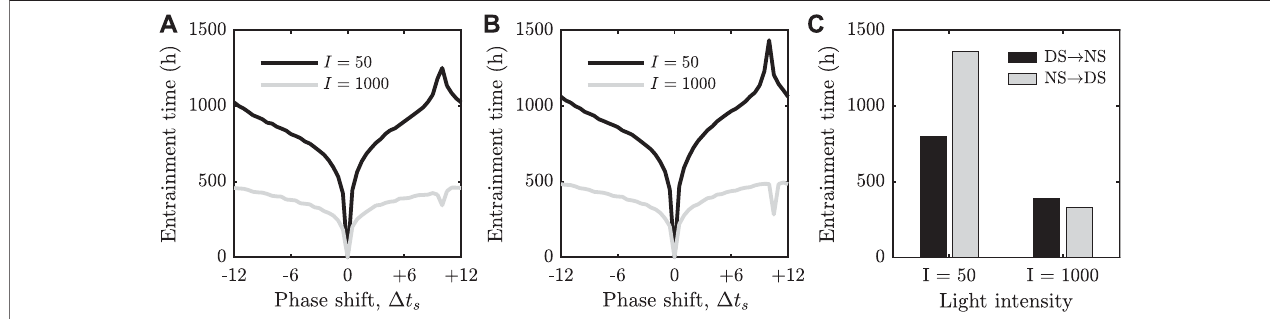
FIGURE 2 | (A) + (B) : Re-entrainment times as a function of the shift in the phase of the external forcing. The FJK model is shown in panel (A) and our two dimensional reduction is shown in panel (B) . For I (cid:1) 50, we observe a peak in the re-entrainment time at around a +10.5 h shift. For I (cid:1) 1000, we now observe a local minimum, rather than a global maximum, in re-entrainment time for a +10.5 h shift in both models. (C) : Re-entrainment times following transitions from day shift to night shift (DS → NS) and from night shift to day shift (NS → DS) in the 2D